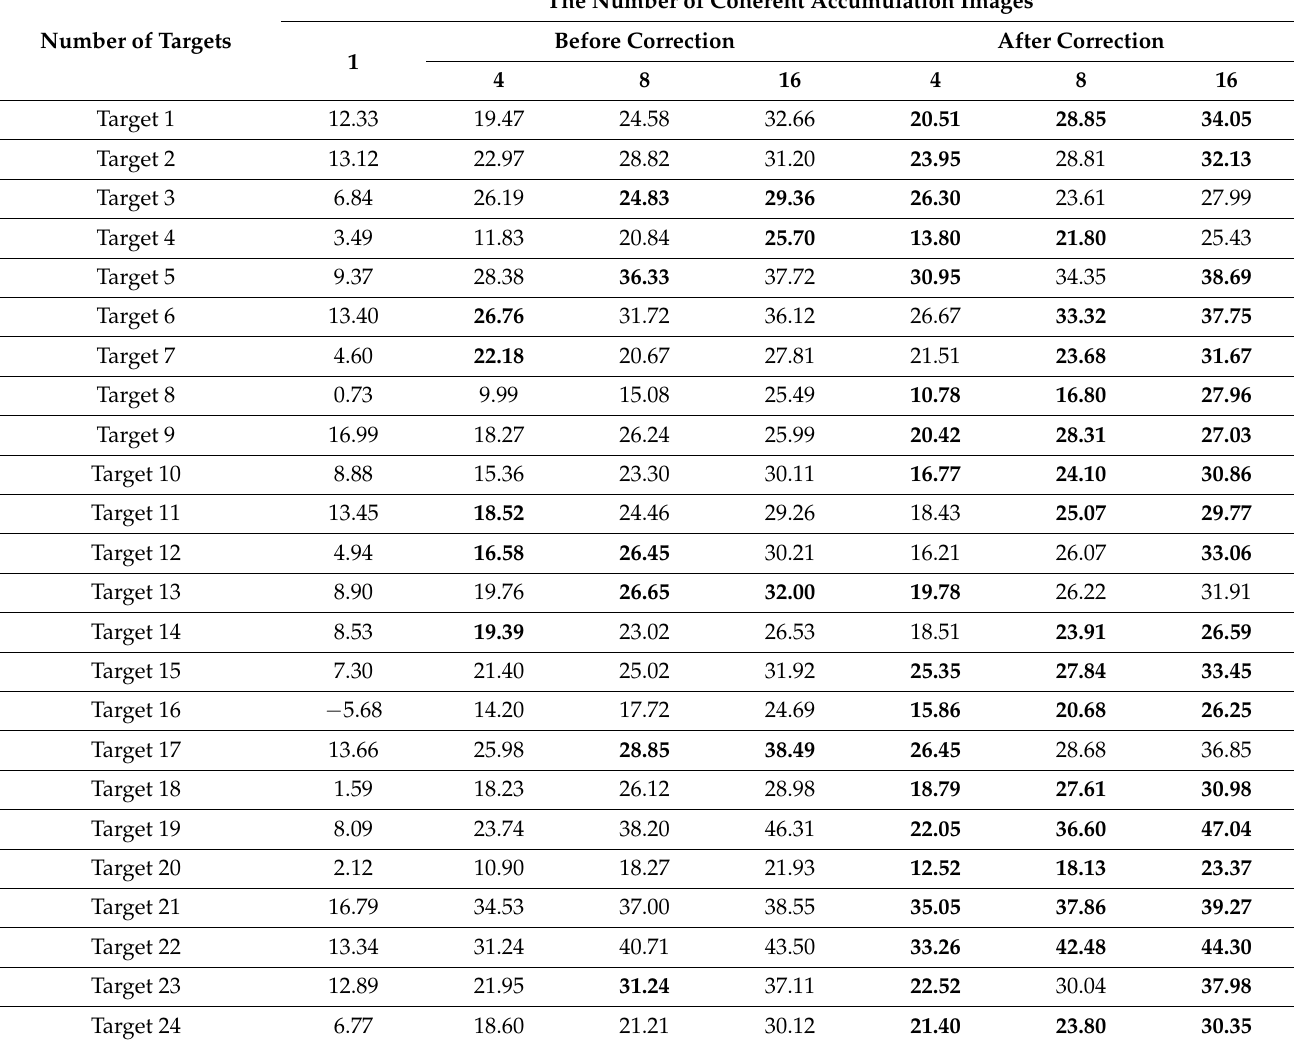
Table 2. The SNR of targets